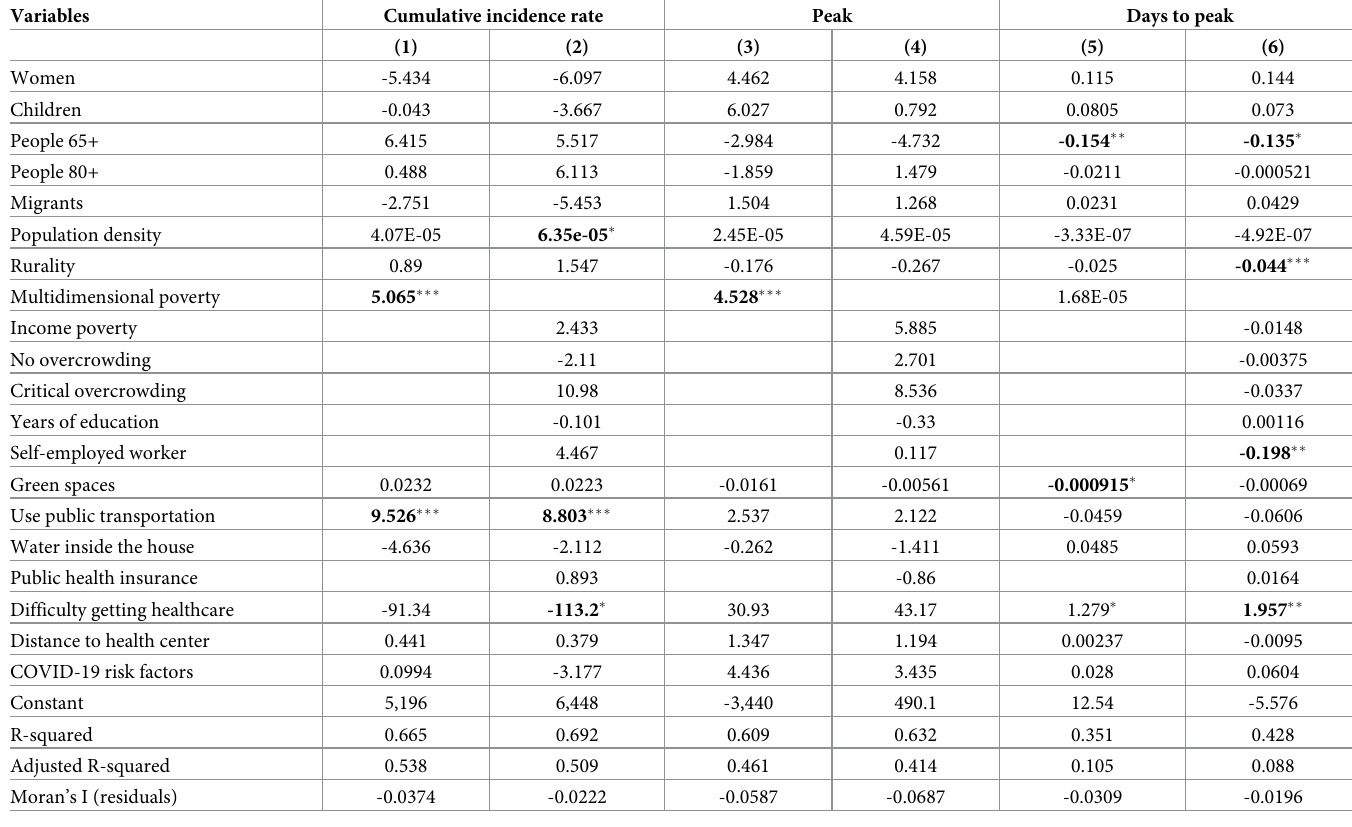
Table 4. Infection regressions